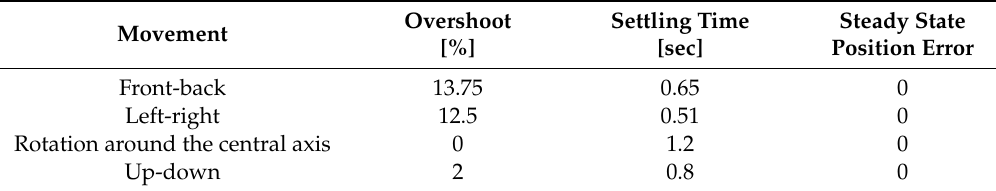
Figure 11. The nonlinear model output for step input on each axis. Table 1. The obtained performance